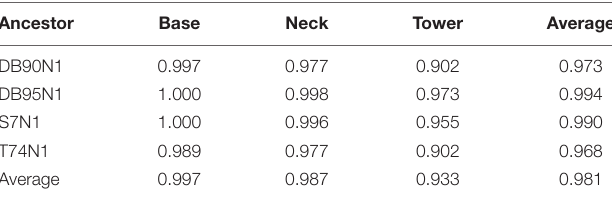
TABLE 3 | Confident probability of candidate sequences among regions. Ancestor